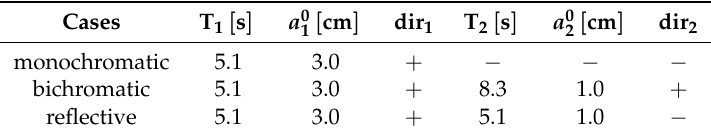
Table 1. Wave conditions in the seaward boundary for the 1D examples: For each wave train (two at most), T j is the period, a 0 is the wave amplitude at x = 0, and dir j is the direction of wave propagation j ( + , rightwards).